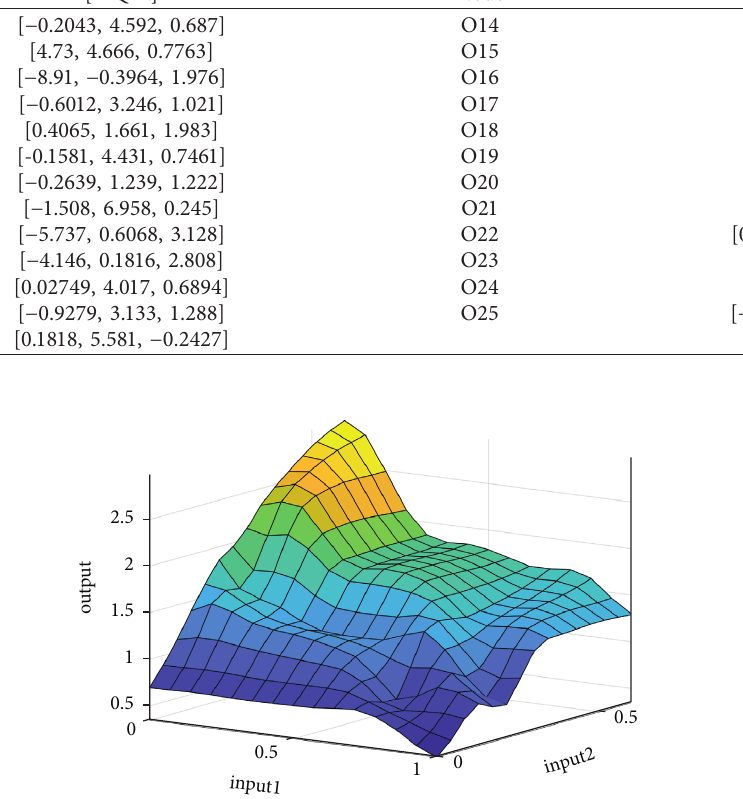
Figure 18: Switching surface of the AFNN output corresponding to the input. Table 7: Equalization time comparison between mean-difference and AFNN algorithm in three